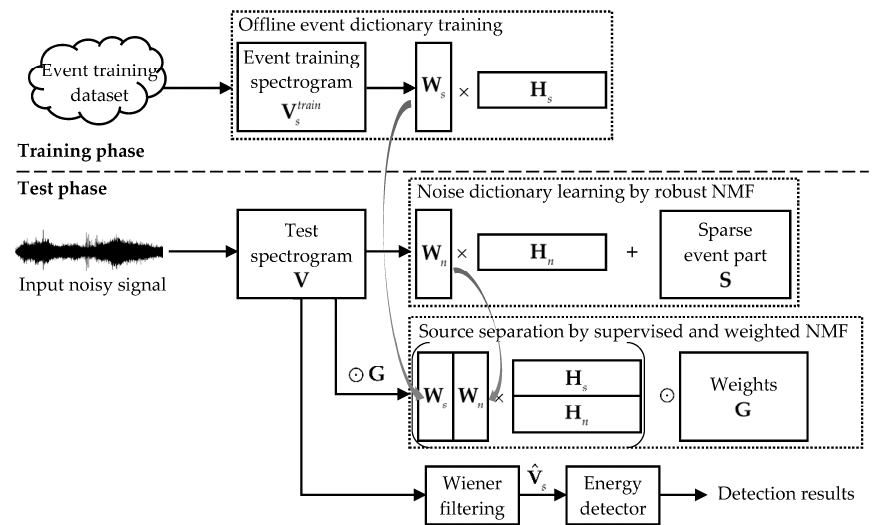
Figure 1. Framework of the proposed sound event detection method based on non-negative matrix factorization (NMF) [14]. 200